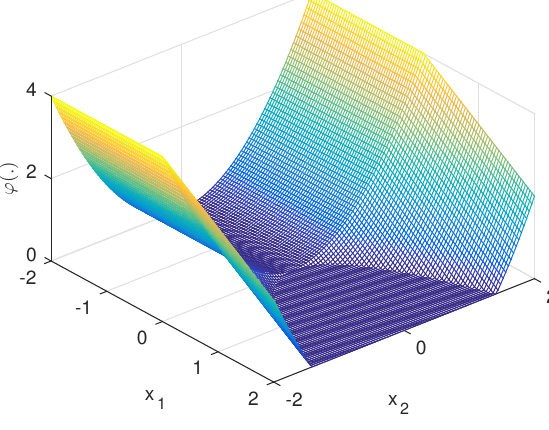
Figure 1. Half pipe example as defined in Equation